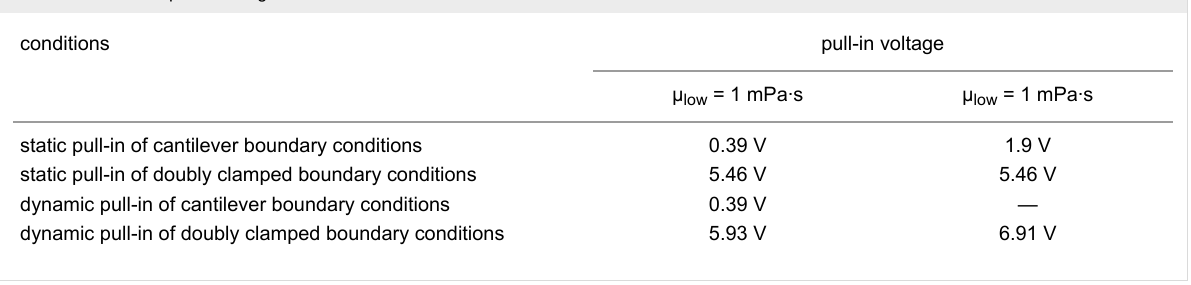
Table 2: Reference pull-in voltages.